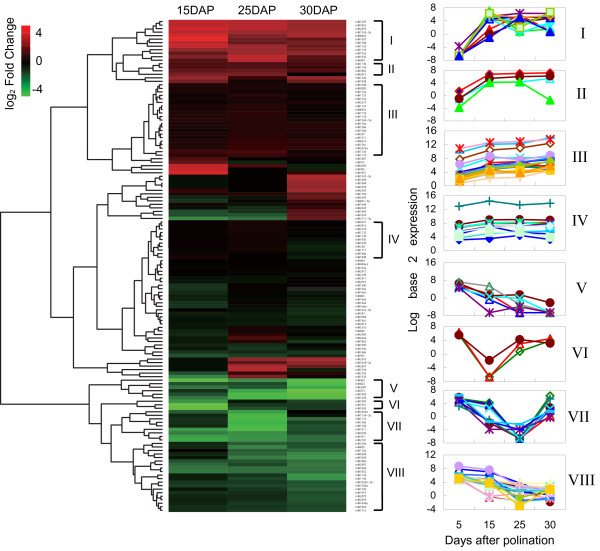
Hierarchical clustering of 140 conserved miRNAs highly expressed in developing grains. Clustering was performed based on fold-changes between 5 DAP and 15, 25 or 30 DAP. I-VIII indicate eight clusters of miRNAs which were potentially involved in the regulation of grain filling.